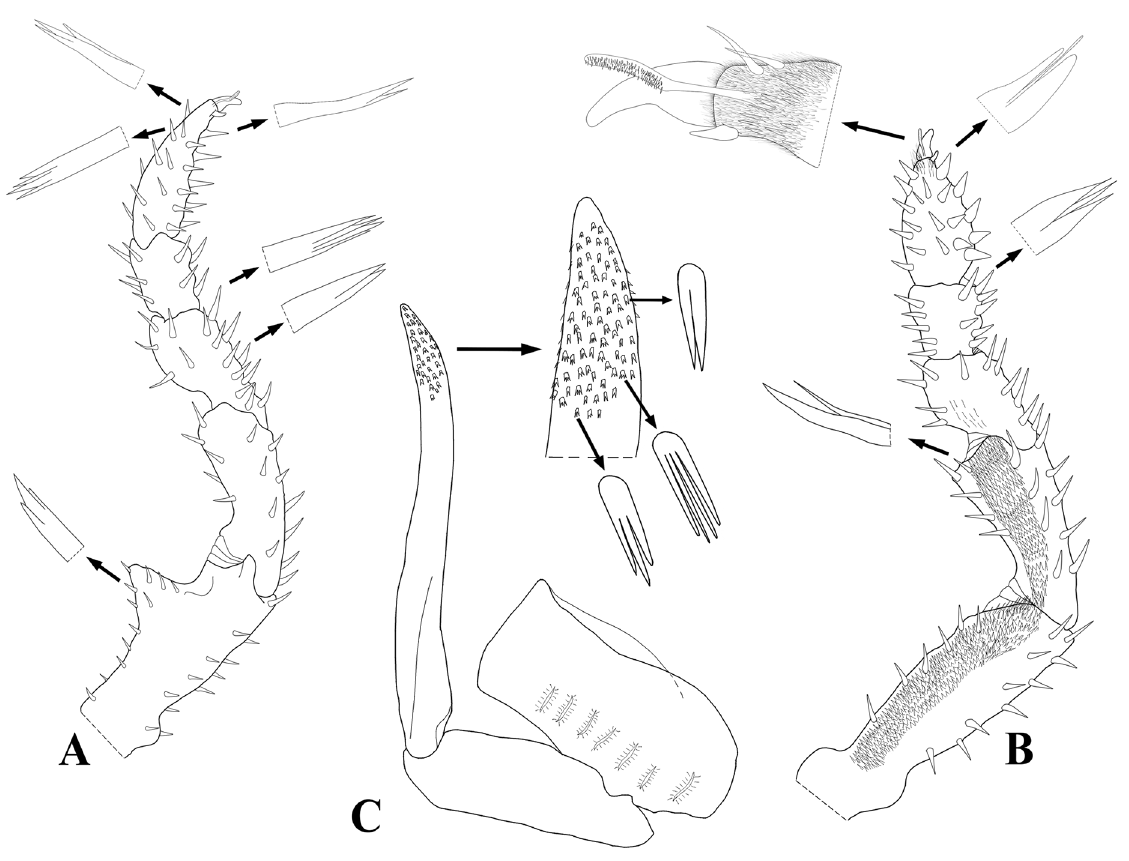
Fig. 5. Tylos negroi López-Orozco, Carpio-Díaz & Campos-Filho sp. nov., paratype, ♂ (CDUC- CRU 128). A . Pereopod 1. B . Pereopod 7. C . Pleopod